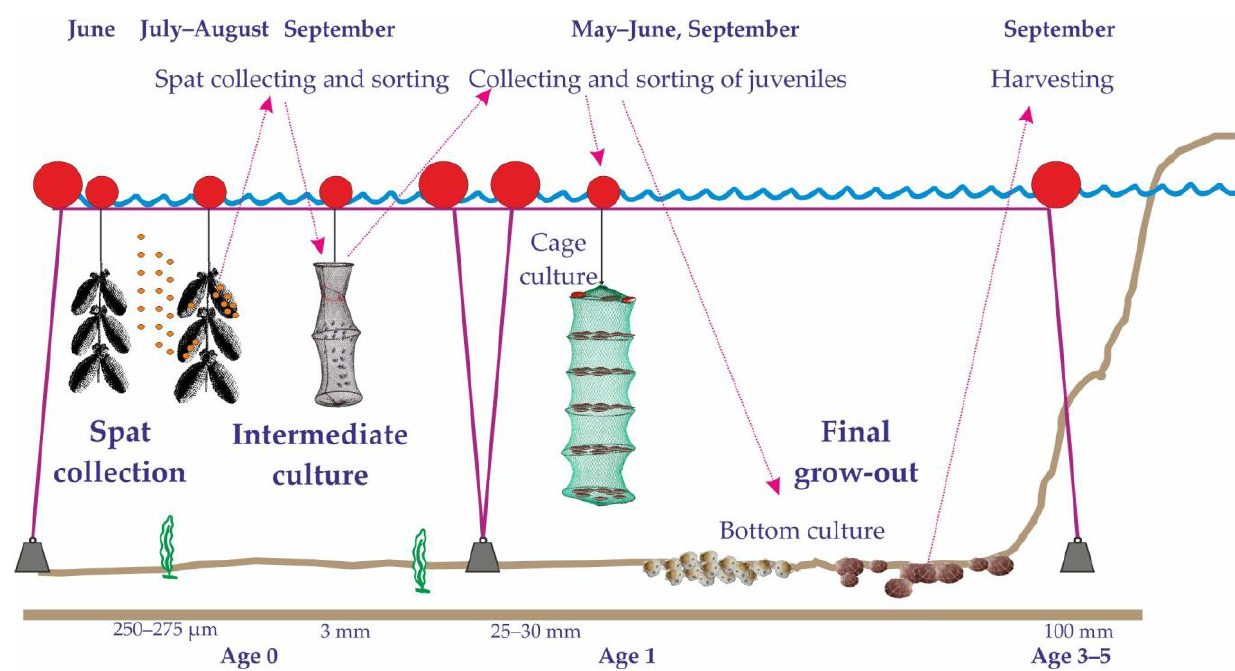
Figure 5. Scheme showing the cultivation process of yesso scallops in the Sea of Japan [19,72]. The main growing areas are situated in Peter the Great Bay. The most important farming sites are Posjet Bay, Amursky Bay, Ussuriysky Bay, and Nakhodka Bay. The most important farms in the coastal zone between Cape Povorotny and Cape Zolotoy are Kievka Bay and Vladimir Bay.